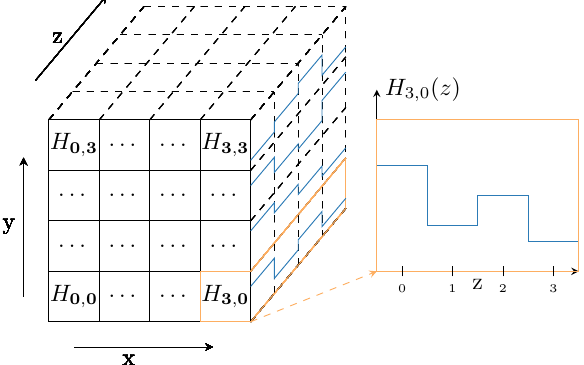
Figure 2. Columns in the z -direction contain the weighted histograms for corresponding pixels. Every pixel has its own local weighted